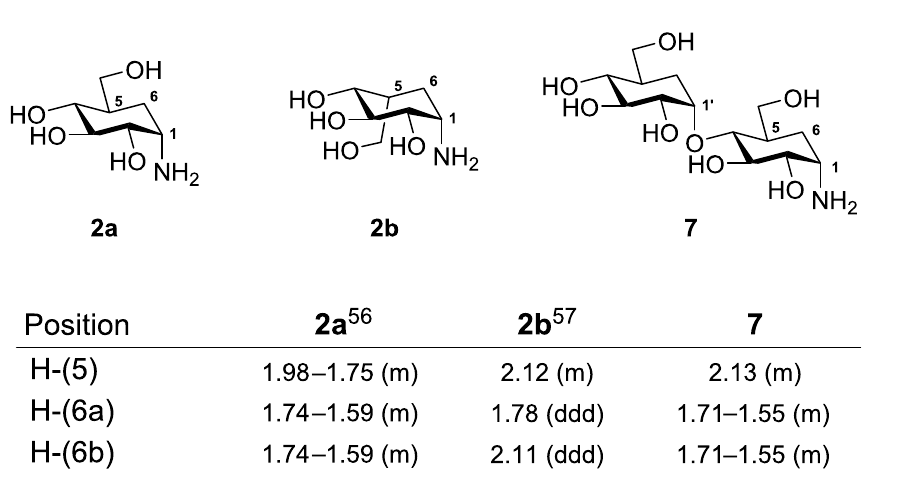
Table 4. Comparing the NMR shift values of validamine ( 2a ), epi -validamine ( 2b ) and 7 .